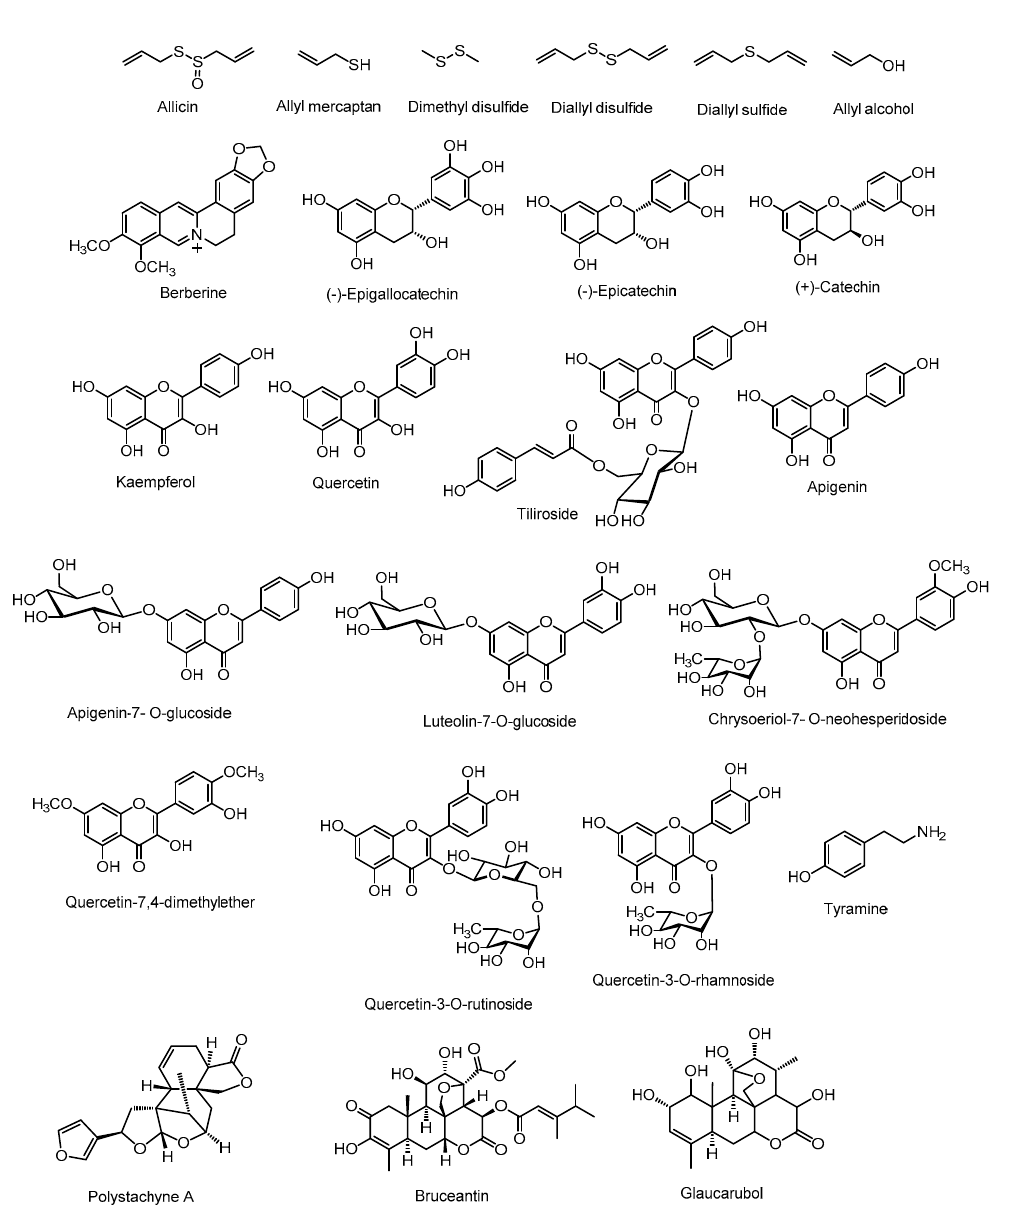
Figure 1. Chemical structures of some of the phytochemicals discussed in this manuscript.